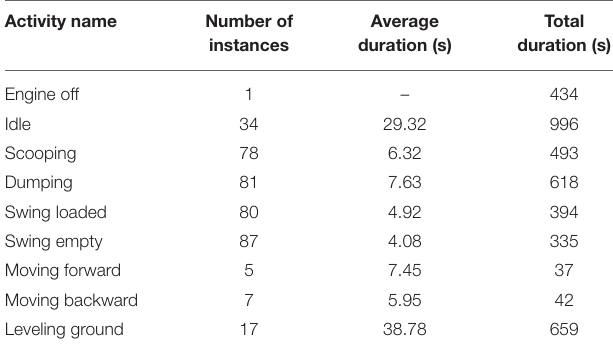
TABLE 1 | Number of instances of each activity with duration for